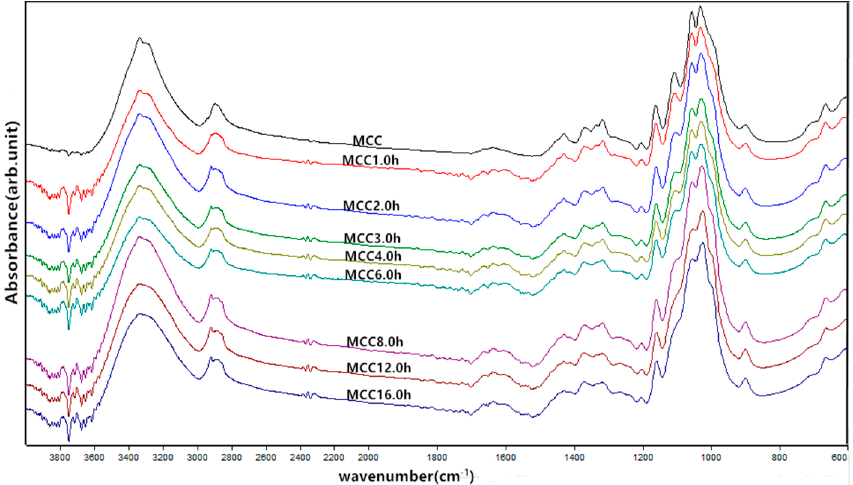
Figure 3. FTIR spectra of MCC samples with different ball milling time.